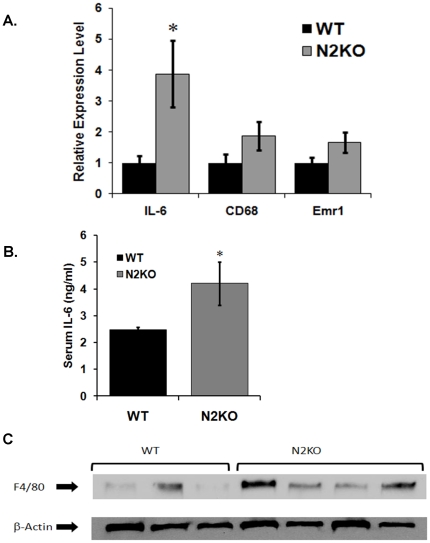
Expression profile for pro-inflammatory genes from WT and N2KO mice.
A. Relative quantitative expression in RNA from WAT isolated from ad lib fed WT and N2KO for interleukin-6 (IL-6), Cluster of Differentiation 68 (CD68) and EGF-like module-containing mucin-like hormone receptor-like 1 (Emr1). The data are reported as mean expression level relative to WT expression ± SEM. (*p≤0.05). B. Serum IL-6 levels were measured from ad lib fed WT and N2KO mice. The data is reported as the serum level (pg/ml) ± SEM (*p≤0.05). C. Western analysis of WAT for F4/80 expression in protein extracted from ad lib fed mice. Equal total protein amounts were added for N = 3 WT mice, and N = 4 N2KO mice.